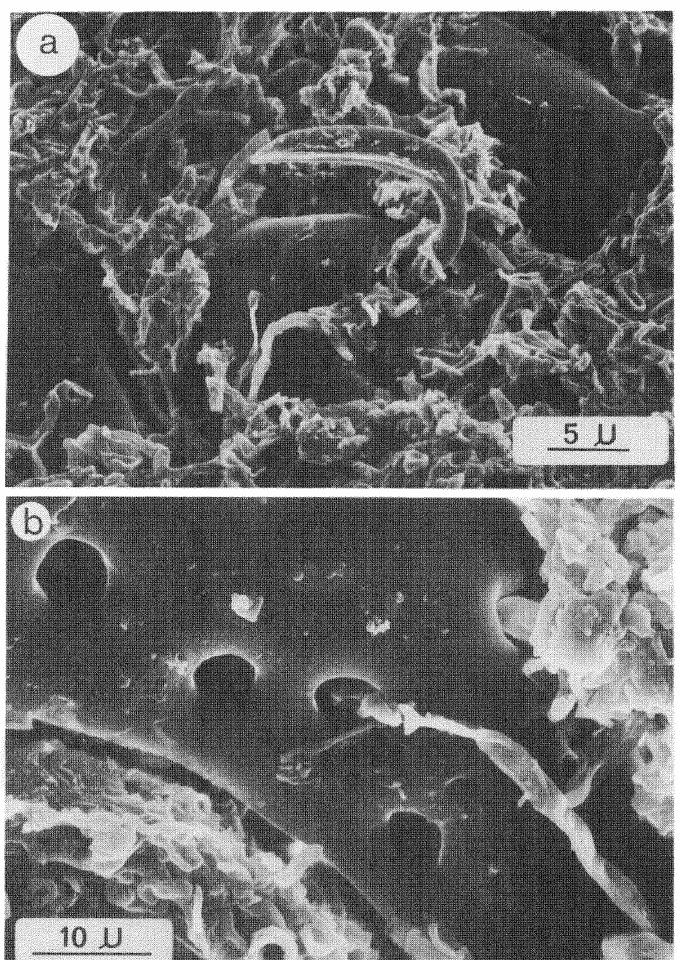
Fig. 5. Z. pallens (same individual as Fig. 4). a. Close up of shoe-horn shaped setae and encrusting ribbons, b. Region on central ridge on which pores are